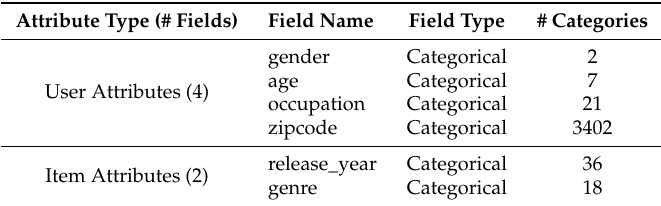
Table 3. Attribute statistics for the Movielens-1M